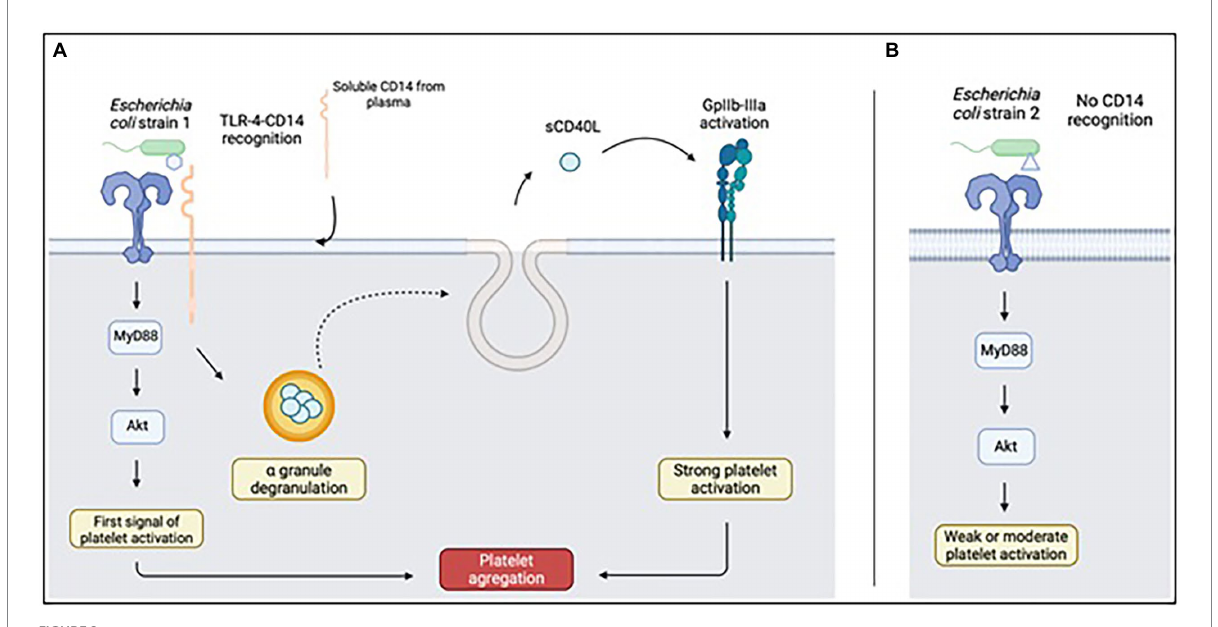
FIGURE 2 Platelet response to LPS recognized (A) or not recognized (B) by CD14. Upon full recognition of the LPS from the Escherichia coli strain, TLR4 will be able to complex with CD14 of soluble origin and be captured by platelets. This mechanism will result in the release of sCD40L present in platelet alpha granules, capable of activating GpIIbIIIa and responsible for platelet aggregation. Diagram created on biorender.com; sCD40L: soluble CD40L.